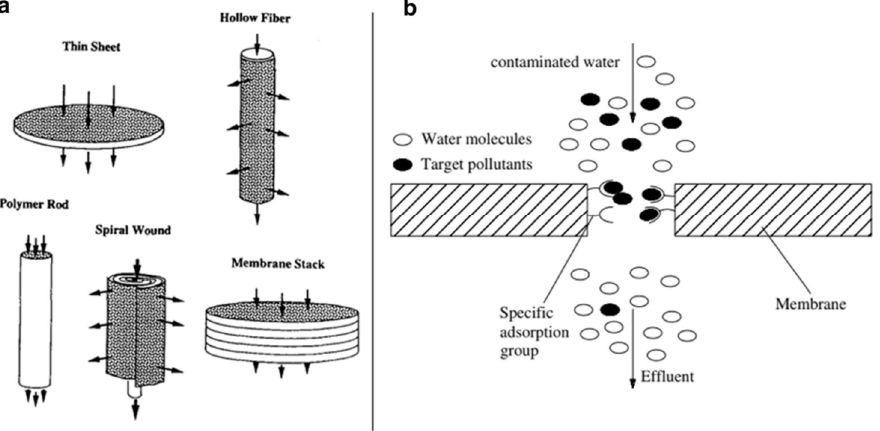
Figure 17. ( a ) Scheme of AMs and arrows note for the directions of bulk flow, and ( b ) the principle of AMs [199]. Table 11. Performance of heavy metal removal using AMs